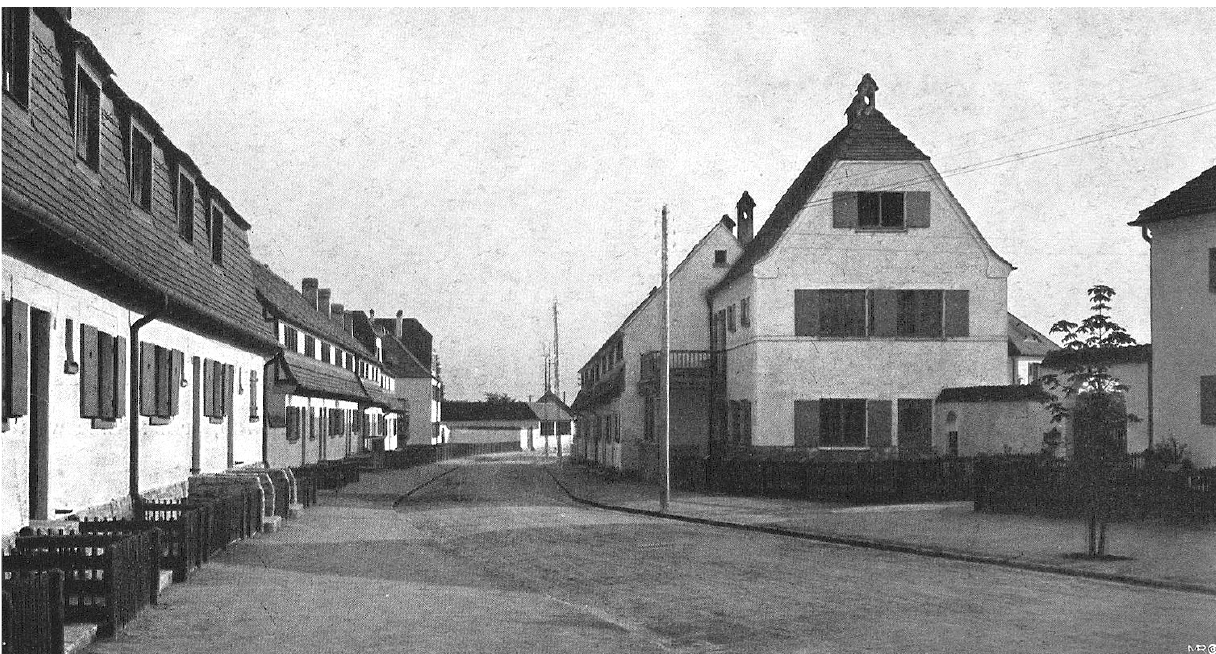
Figure 7. Photograph of Riemerschmid’s housing group on the street “Am grünen Zipfel.” Source: Breuer (1911, p. 458). Urban Planning, 2022, Volume 7, Issue 1, Pages